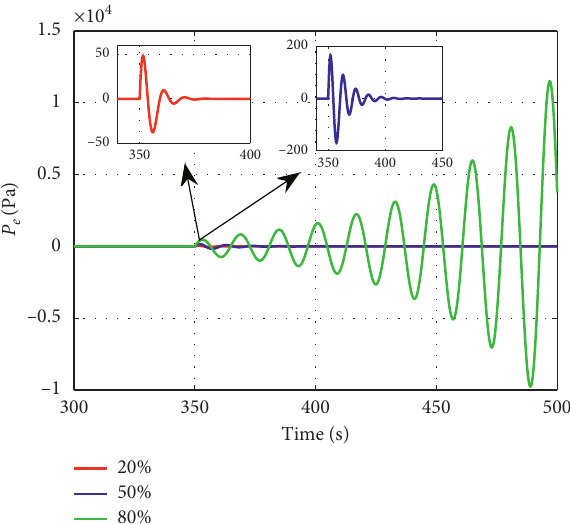
Figure 9: Pressure error caused by the actuator partial failure.